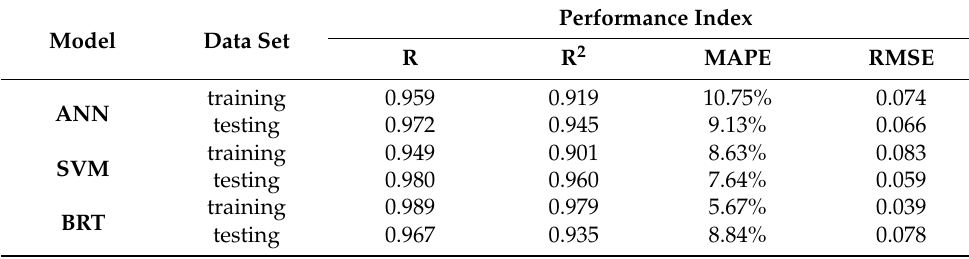
Table 5. Comparison of model performance for predicted AC surface layer modulus (E AC